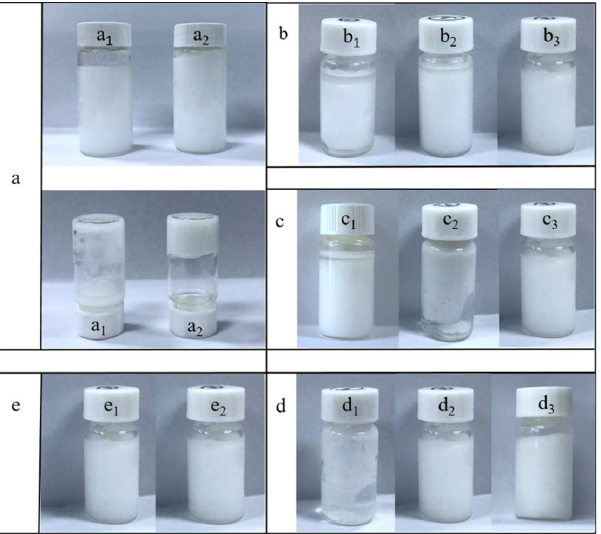
Figure 5. Stability of the Pickering emulsion under different synthetic conditions: ( a ) effects of the